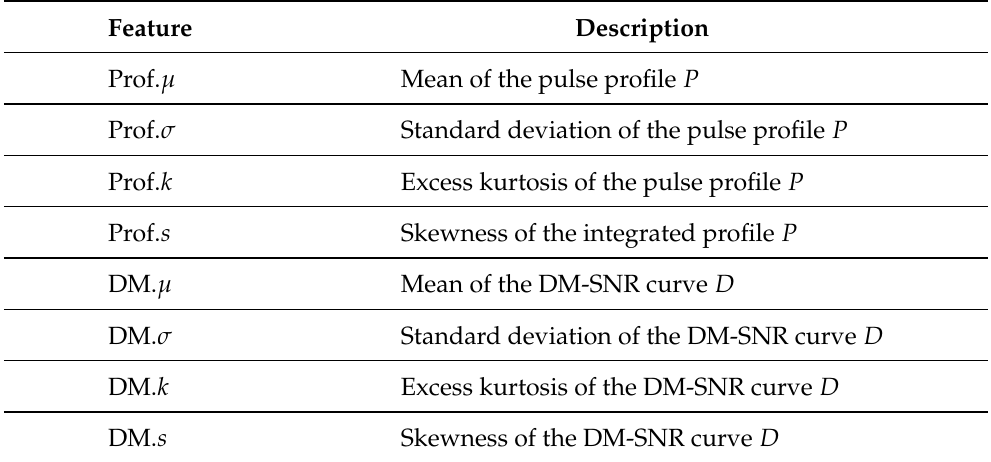
Table 4. Details of eight statistical features designed by Lyon et al. (2016)